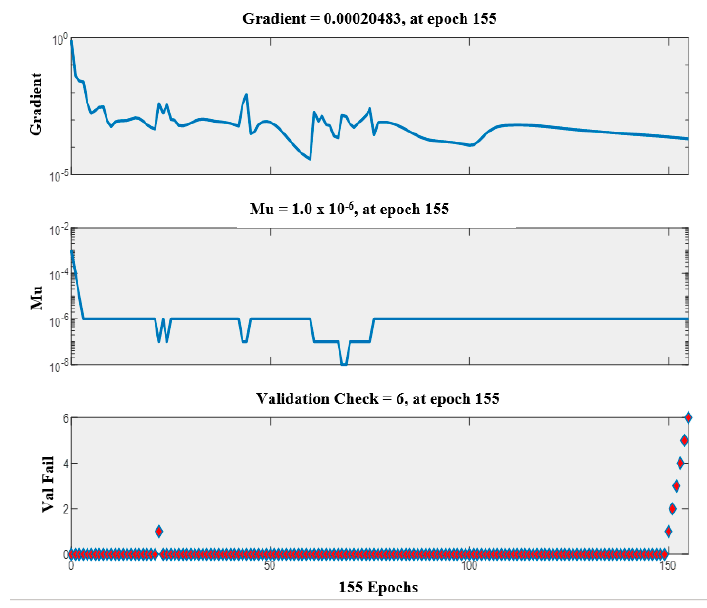
Figure 5. ANN training state.